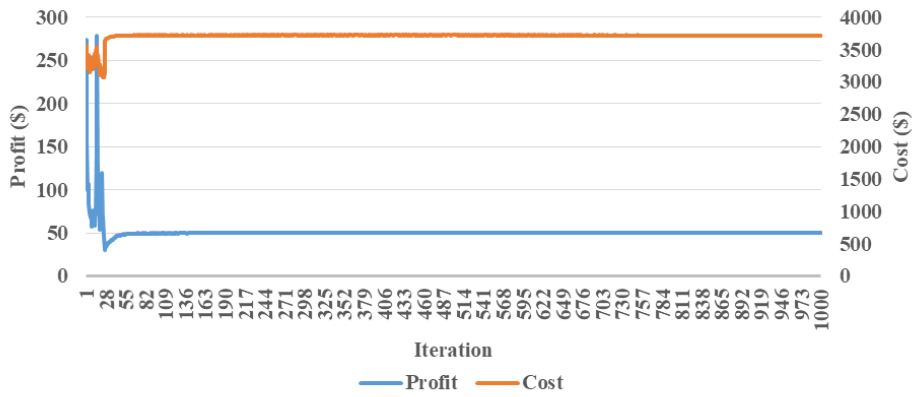
Figure 8. Retailer’s profit and prosumer cost convergence curve in a 30% demand